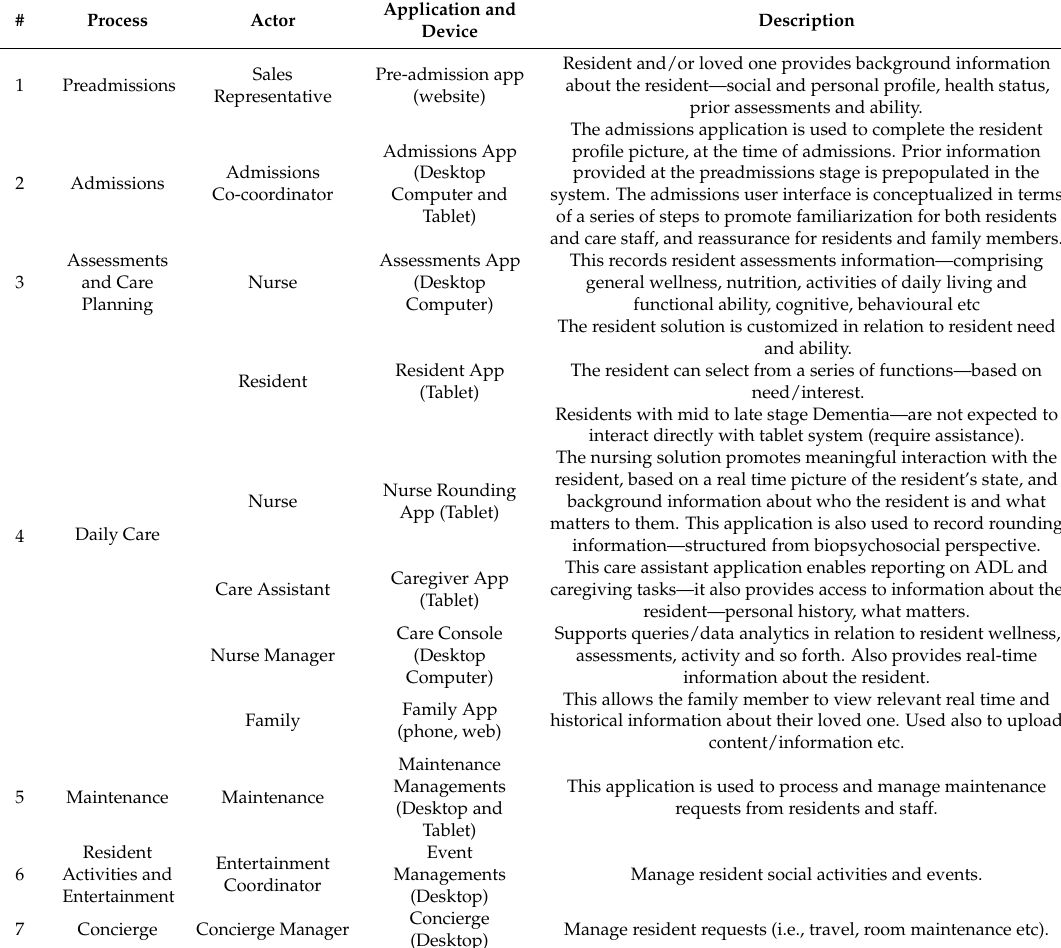
Table A5. Overview of Solutions for Different